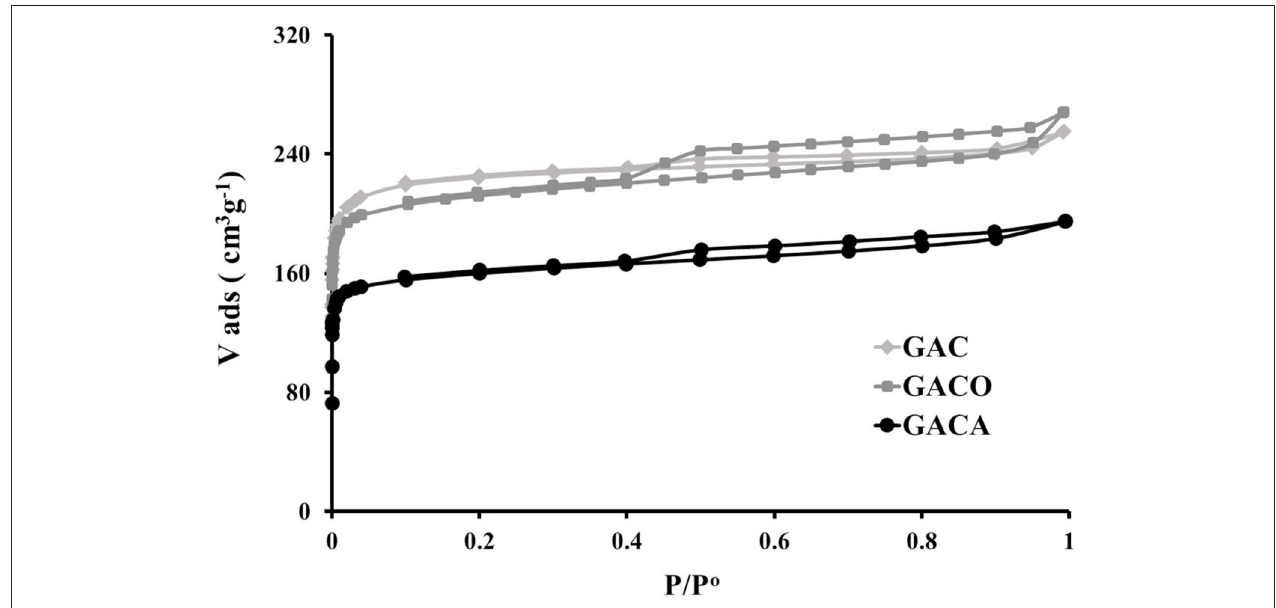
FIGURE 1 | N 2 adsorption isotherms at 77K for prepared samples.